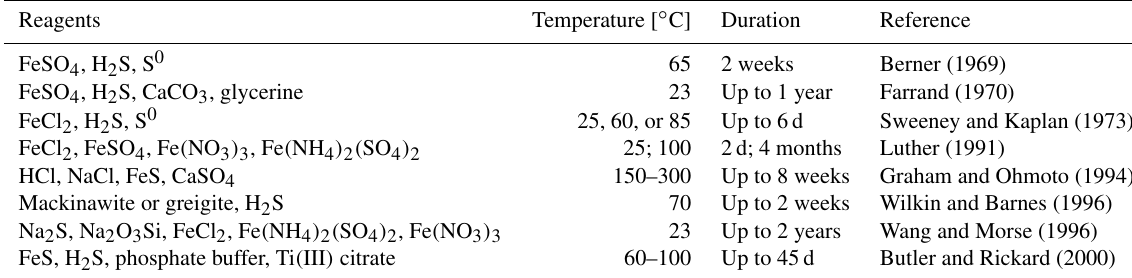
Table 2. An overview of the experimental conditions used to obtain framboid structures (literature data).